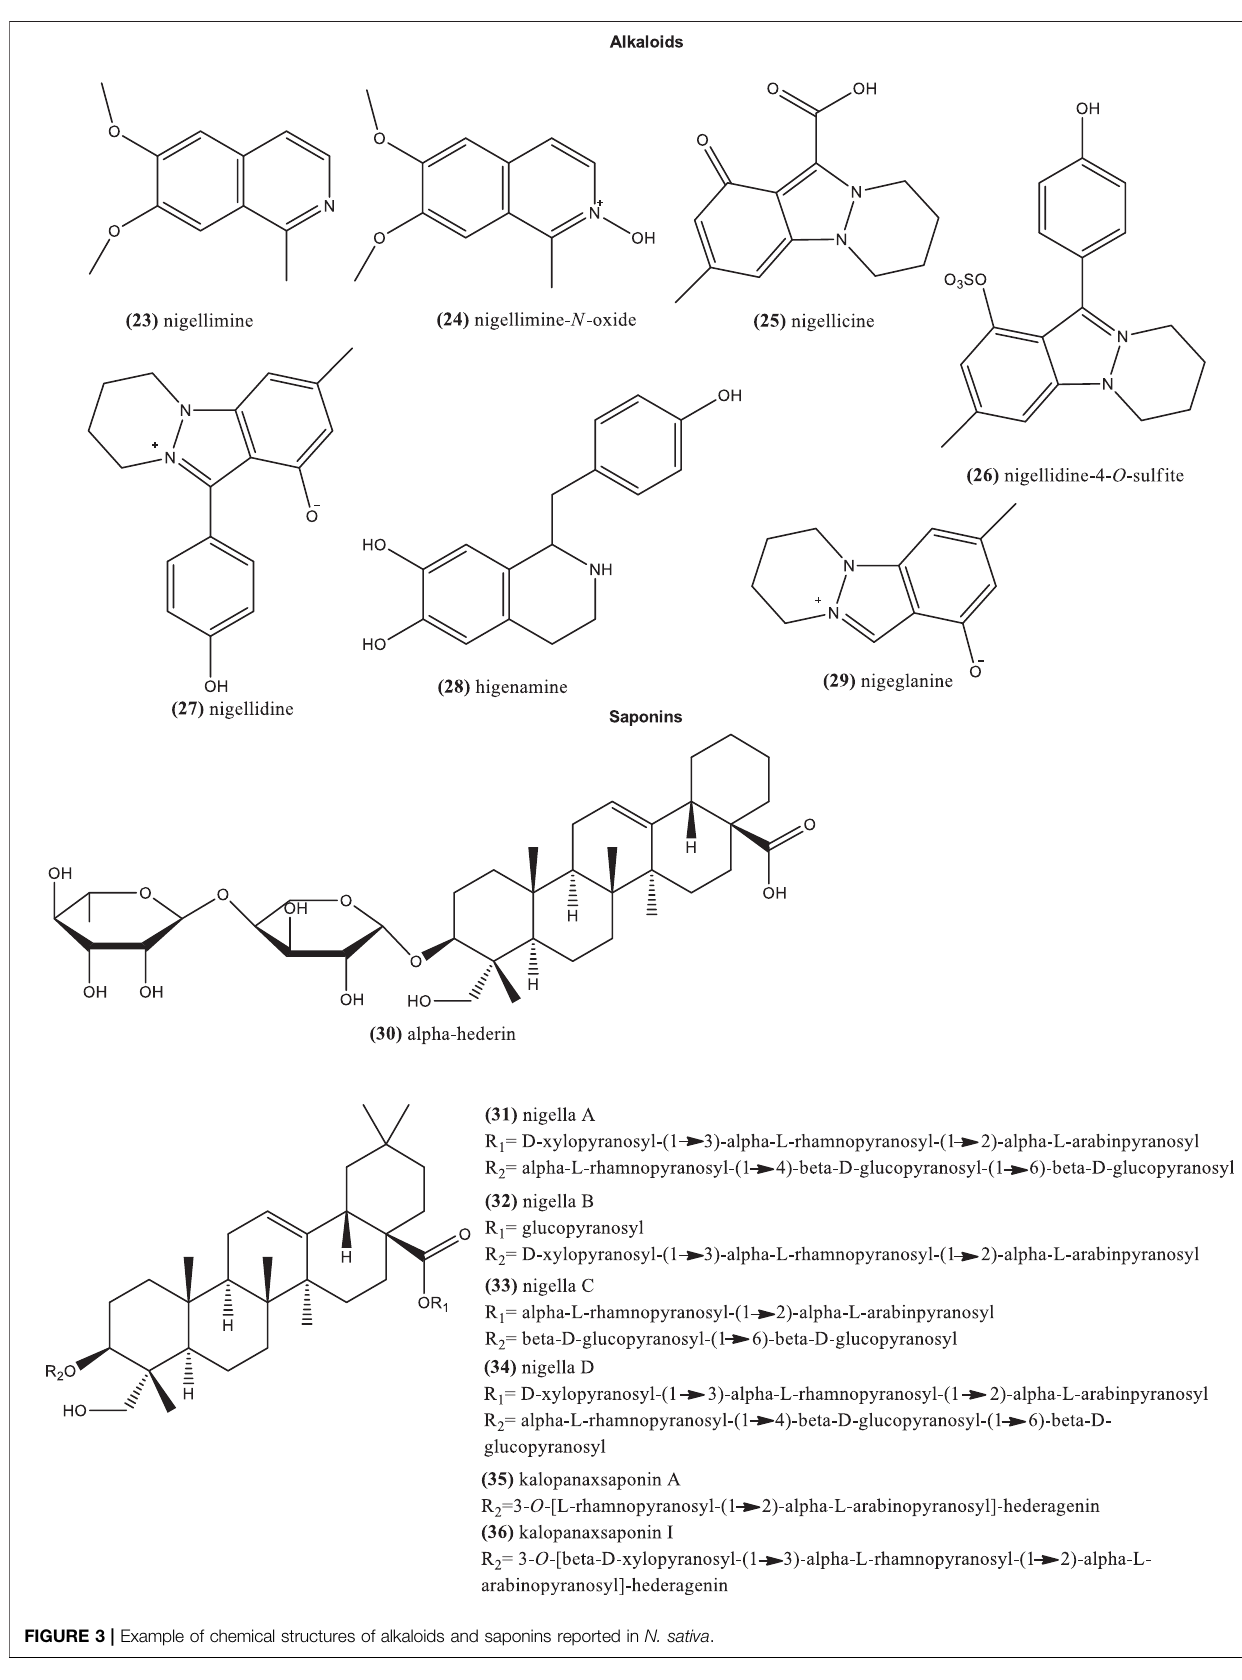
Frontiers in Pharmacology |